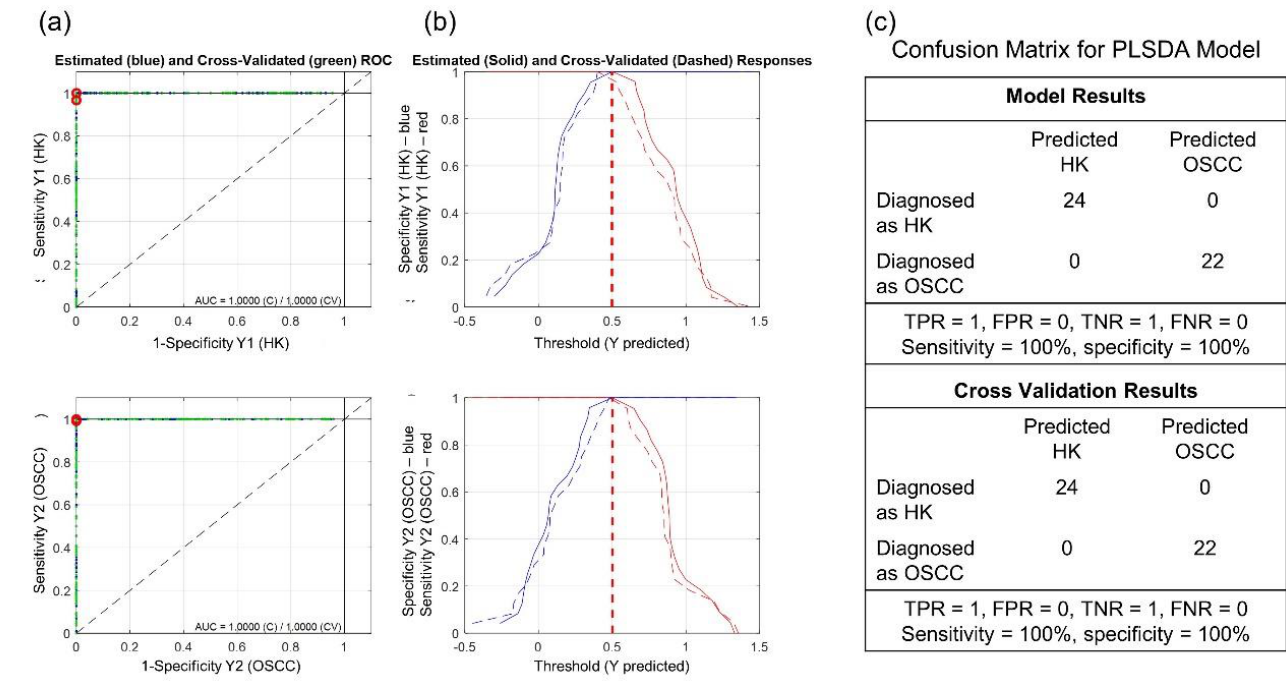
Figure 7. ( a ) Receiver operating characteristic (ROC) curves with area under the curve (AUC) values (AUC = 1); ( b ) sensitivity and specificity curves vs. threshold; and ( c ) confusion matrix for the partial least square discriminant analysis (PLSDA) model. TPR is true positive ratio, FPR is false positive ratio, TNR is true negative ratio, and FNR is false negative ratio.